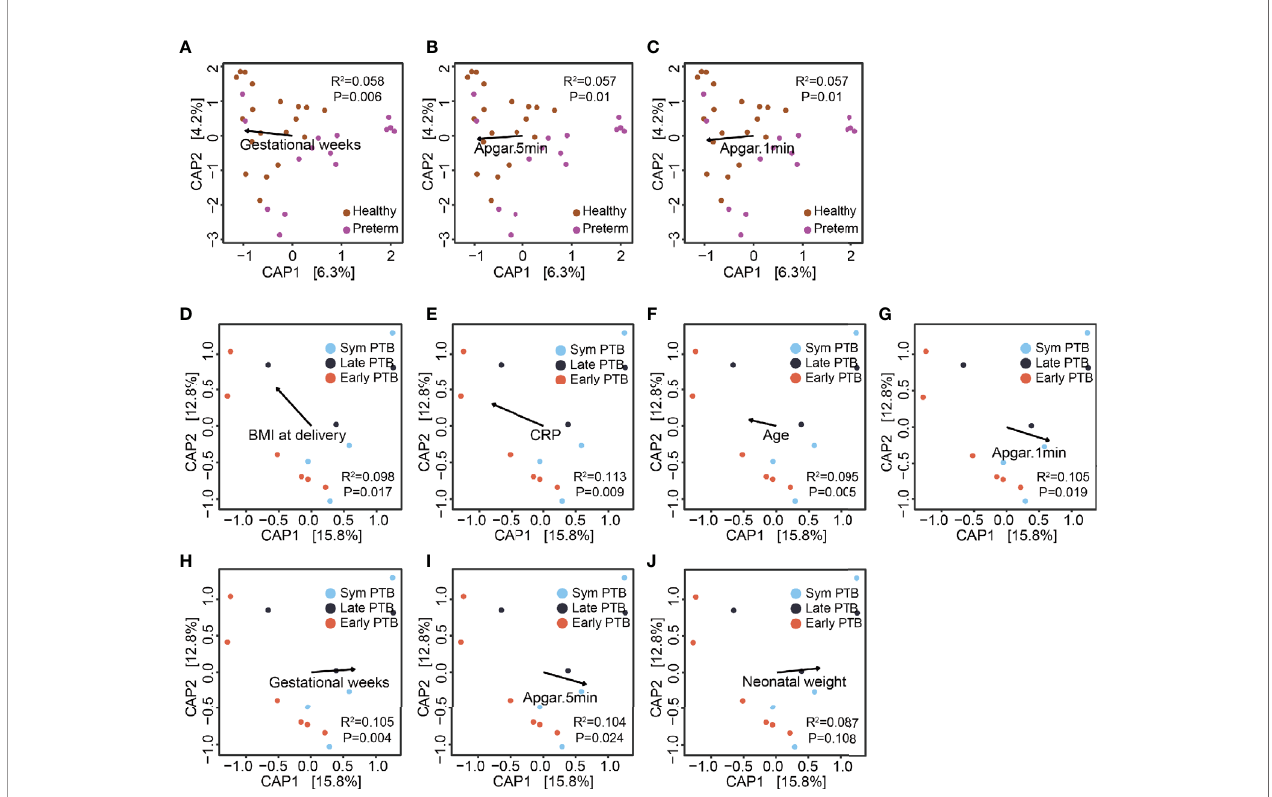
FIGURE 2 | The association of the gut microbiome and host parameters. (A – C) Clinical features ’ projection on all samples. The projection of continuous parameters in the healthy group and the preterm group samples, based on the Bray – Curtis distance metric, gestational weeks (A) , Apgar score at 5 min (B) and Apgar score at 1 min (C) , respectively. (D – J) Clinical features projection on preterm birth subgroups. The projection of continuous parameters in the preterm subgroup samples, based on the Bray – Curtis distance metric, BMI at delivery (D) , CRP (E) , age (F) ; Apgar score at 1 min (G) gestational weeks (H); Apgar score at 5 min (I) and neonatal weight (J) ,